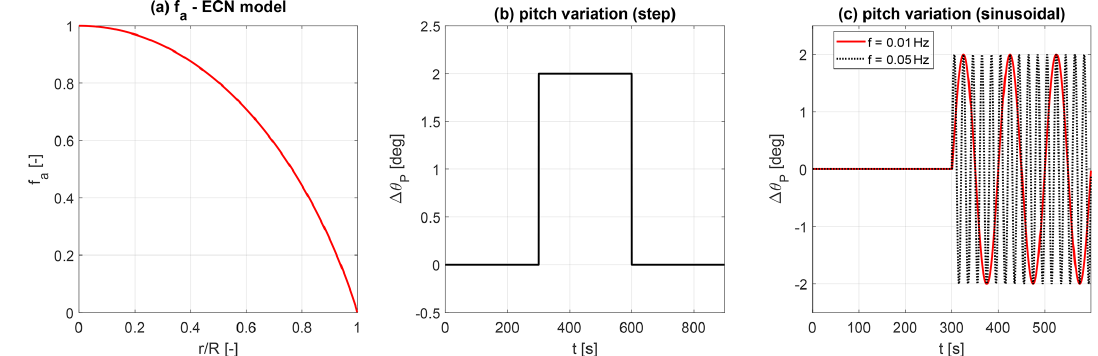
Figure 2. Radial evolution of the ECN model parameter f a (a) ; blade pitch time history for the pitch step case (b) ; blade pitch time history for the two sinusoidal pitch cases (c) .